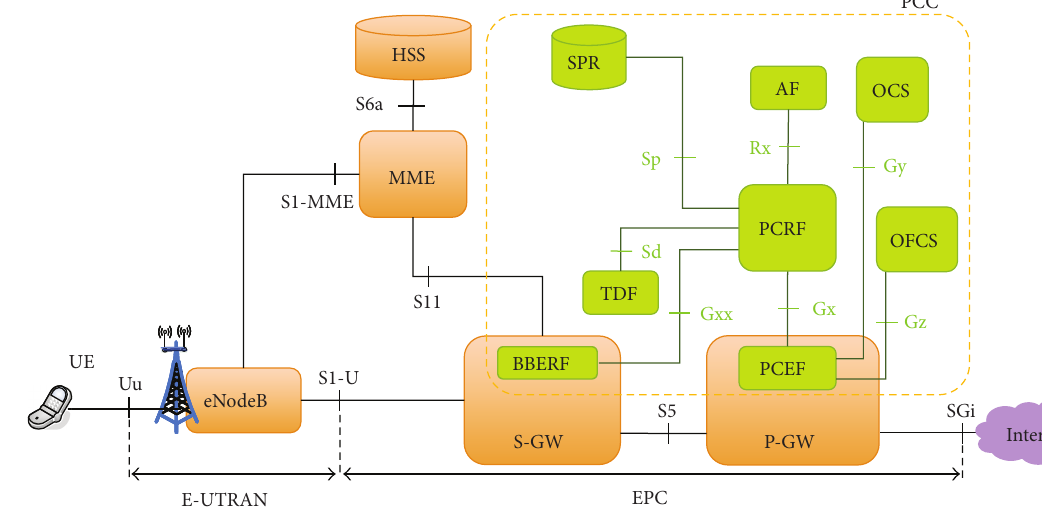
F 1: High level architecture for 3GPP LTE and LTE-A